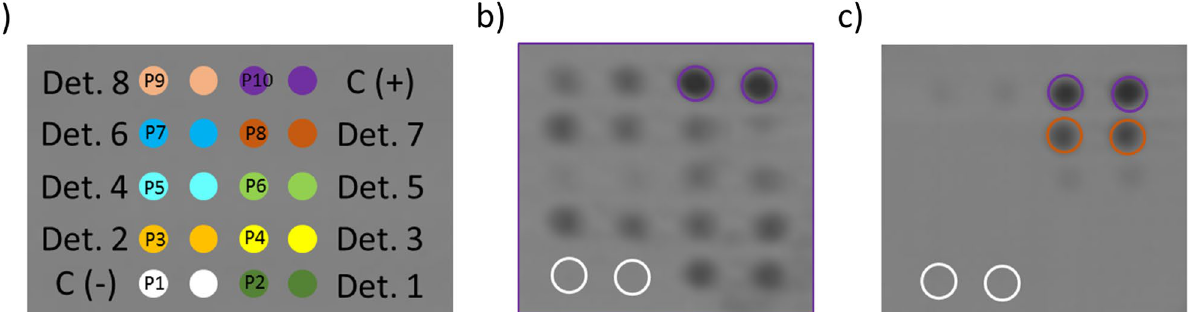
Figure 5. ( a ) Layout of the multiplexed microarray. Position 1: HSA, negative control, C(−); and Position 10: rIgG or hIgE, positive control, C(+); ( b ) Image of an array on the DVD after immunoassay I with α-IgG to CFT, dilution factor 1/1,000 (Position P1: HSA, negative control; P2: CFT-HSA-llanyl determinant; P3: CFT- HSA-lloyl determinant; P4: CFT-H1-lloyl determinant; P5: CFR-HSA-llanyl determinant; P6: CFO-H1-llanyl determinant; P7: CFR-H1-lloyl determinant; P8: CFR-H1-llanyl determinant; P9: CFO-H1-llanyl determinant; P10: rIgG); ( c ) Representative result of the array with specific determinants and controls printed on the DVD after immunoassay II with patient 002 (determinants in the same positions as in ( b ), except for P10: